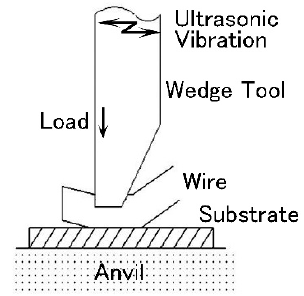
Figure 2. Schematic illustration of the ultrasonic welding machine.